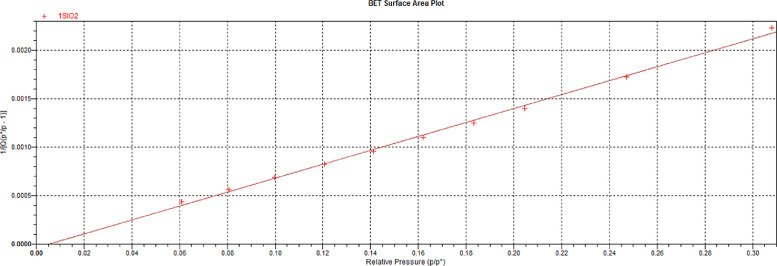
BET Surface Area Plot for the Silica Gel (SiO2).